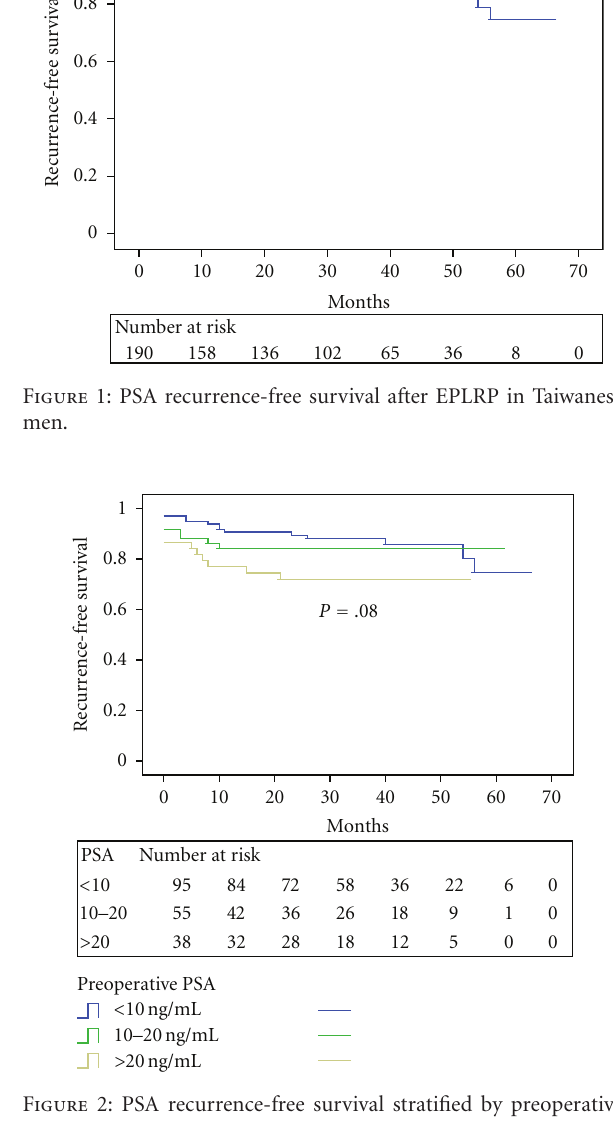
Figure 2: PSA recurrence-free survival stratified by preoperative PSA